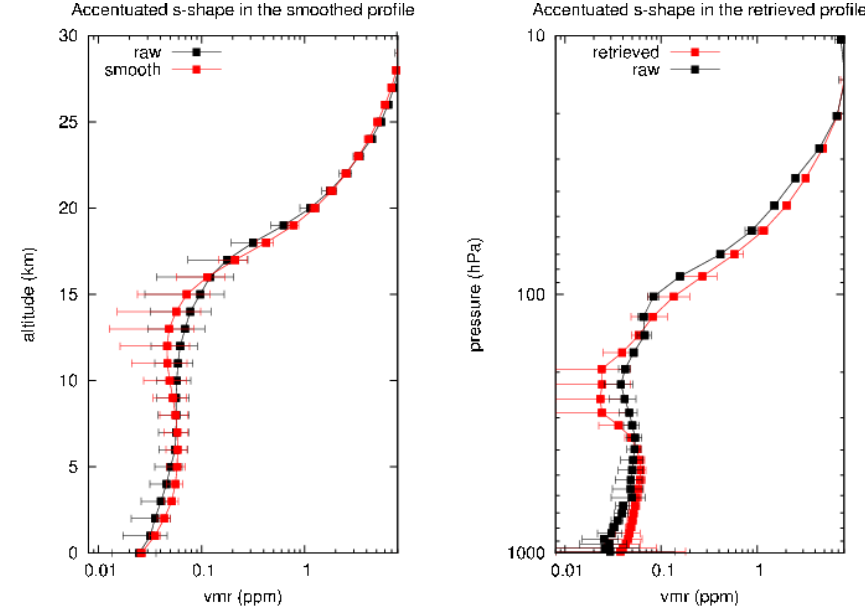
Fig. 13. Effect of the unrealistic accentuation of the “s-shape” of the tropical ozone profile during the smoothing (left panel) and the retrieval (right panel) processes. This effect is visible when comparing the 1 σ error bars.